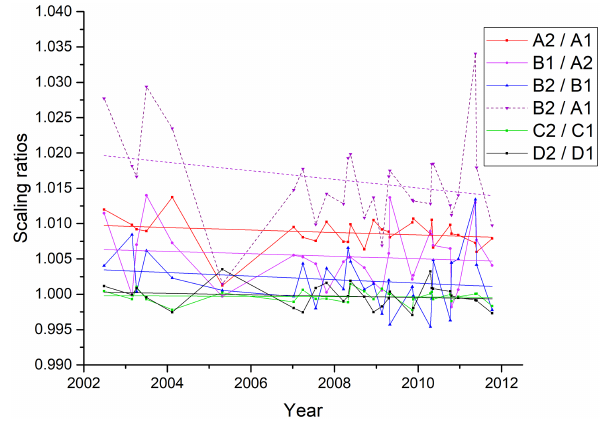
Figure 11. Scaling ratios between overlapping channels deduced from IF16 measurements over the mission. A linear fit to the data has been added.